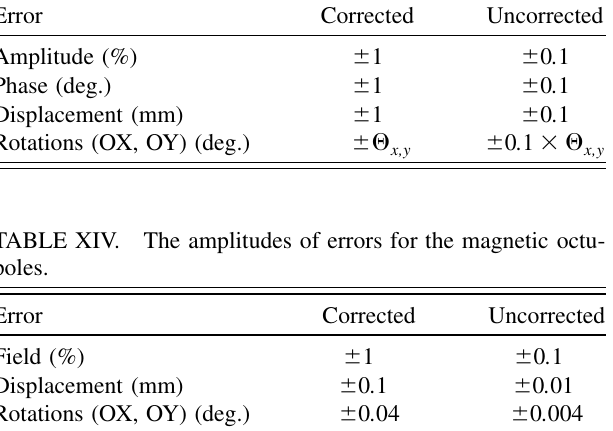
TABLE XIII. The amplitudes of errors for the SC cavities.